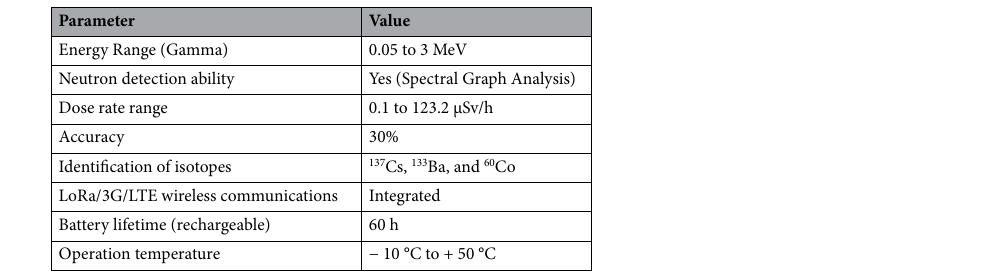
Table 3. Specifications of the mobile radiation device.